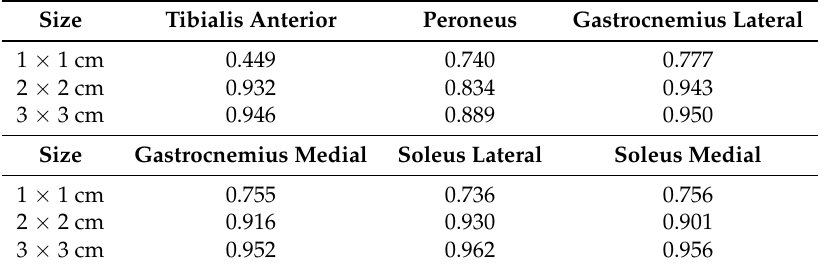
Table 2. Correlation coefficients under electrode size conditions.